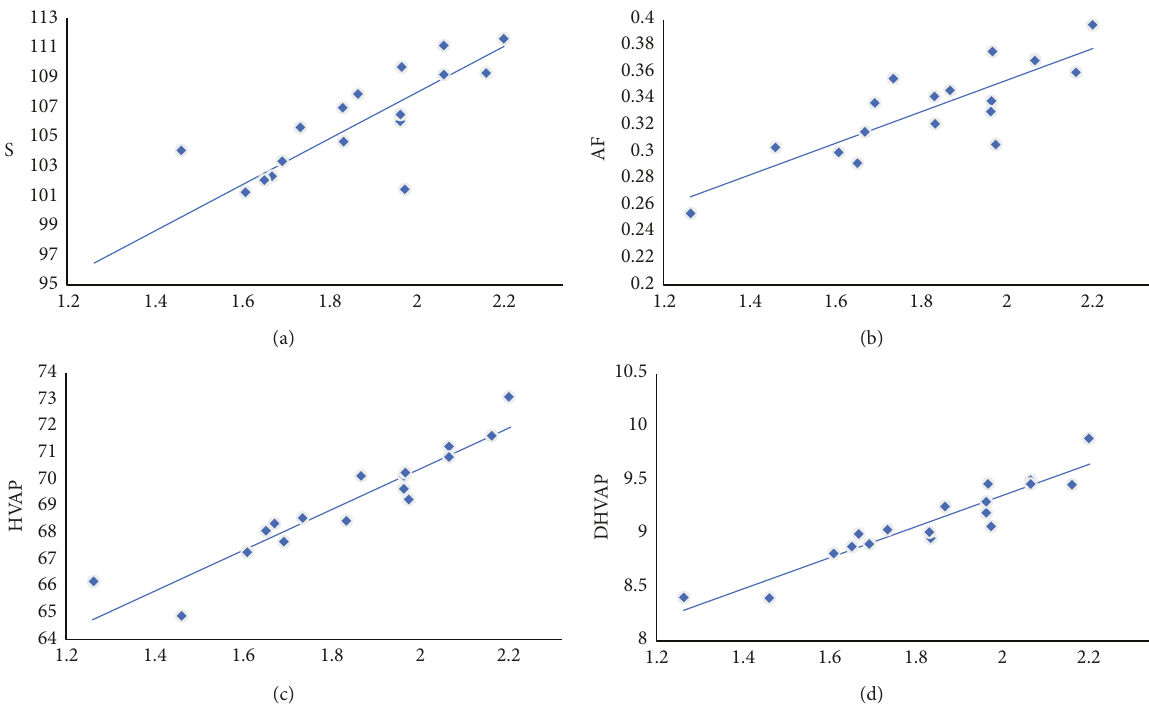
Figure 3: Correlation of HG ( x -axis) and physical properties S, AF, HVAP, and DHVAP ( y